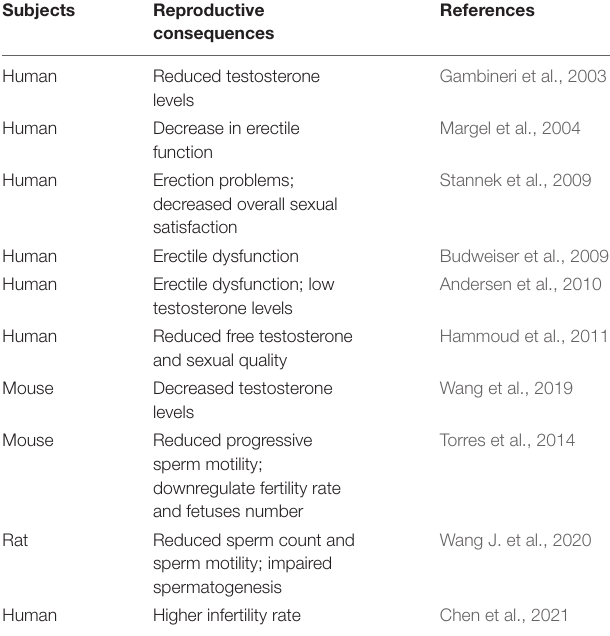
TABLE 4 | Summary of the studies reporting the reproductive consequence of sleep